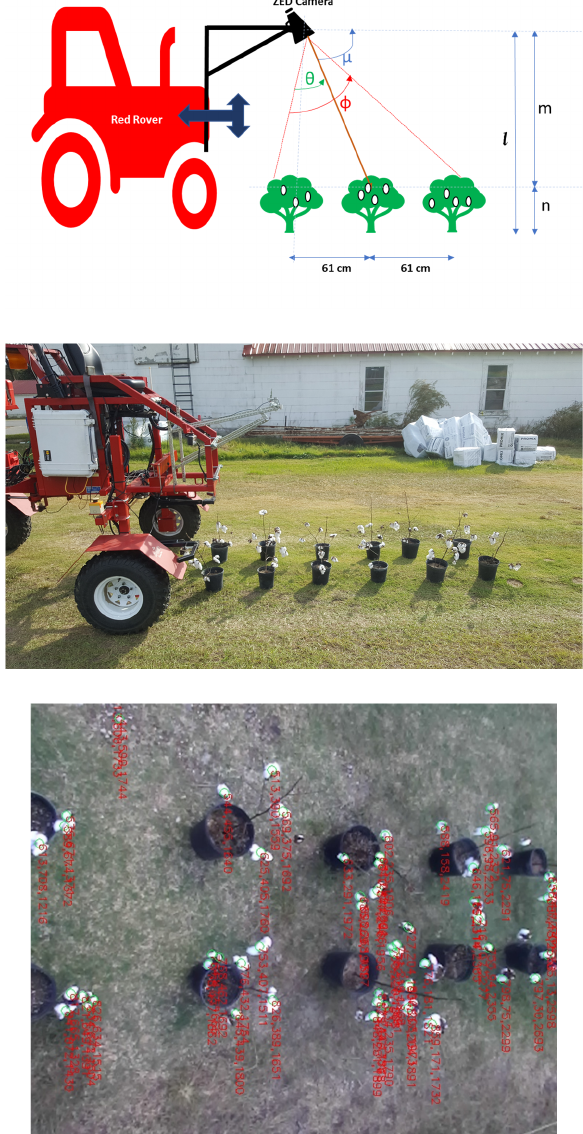
Figure 9. Context diagram that shows cotton boll position measurements.